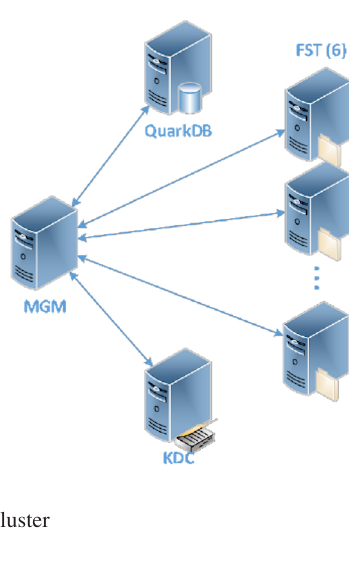
Figure 5. Docker based EOS